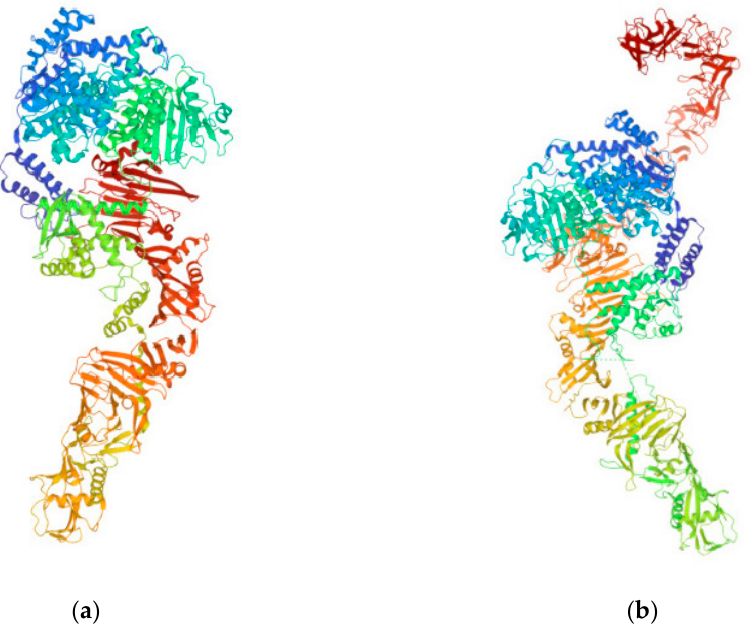
Figure 4. TcdA ( a ) and TcdB ( b ) from C. difficile (https://www.rcsb.org/3d-view/4R04 and https://www.rcsb.org/structure/6OQ5, respectively; both links were accessed on 14 December 2022). These toxins disrupt the tight junctions and the cytoskeletal structure of target human cells, which ultimately leads to cell death, and serve as targets for C. difficile vaccines.